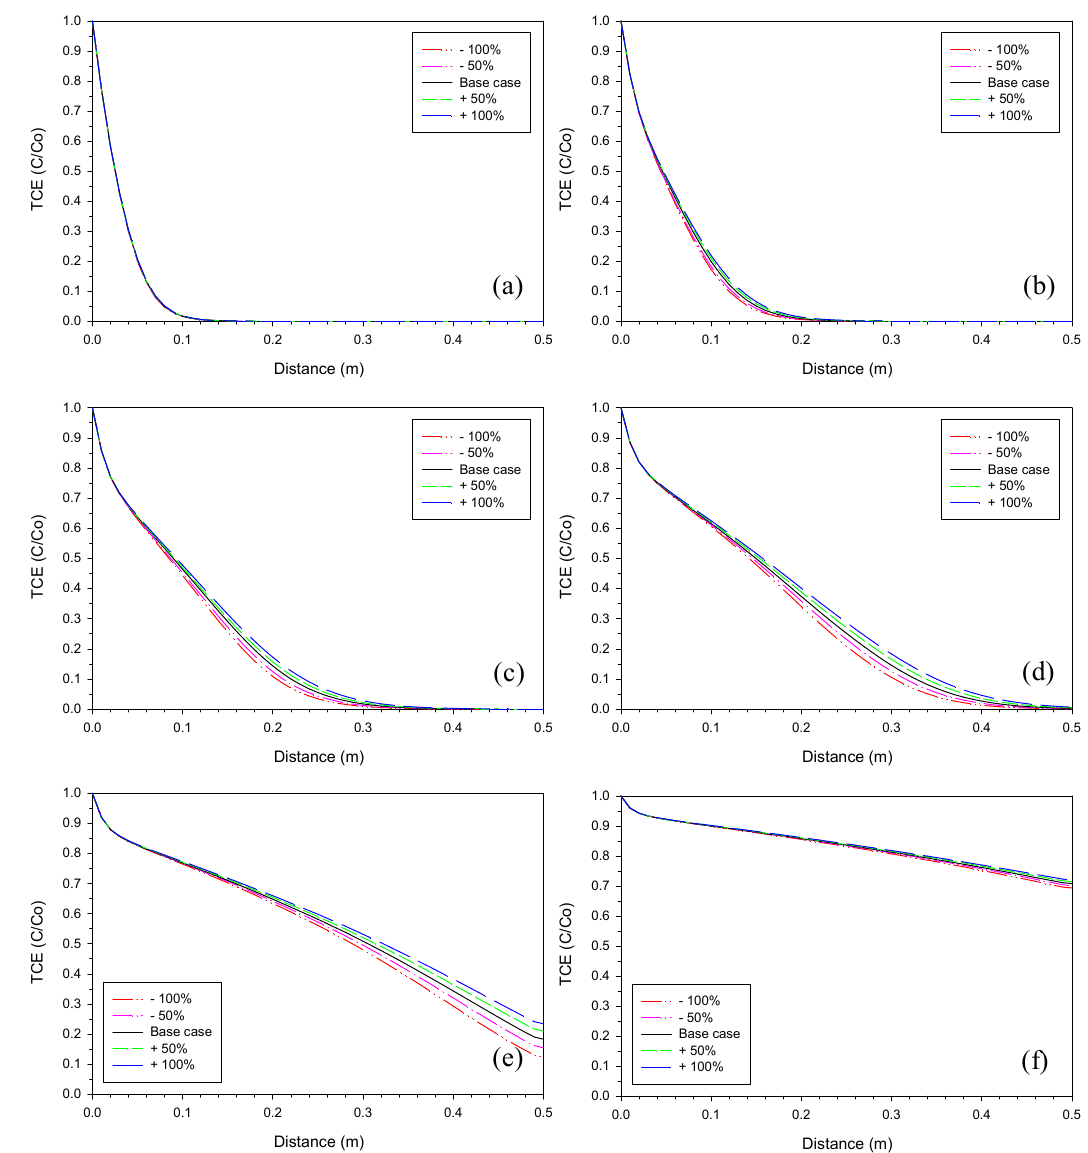
Figure 9. Sensitivity analysis of α 2 (proportionality constant for Fe 2 (OH) 2 CO 3 (s)). TCE profiles on ( a ) Day 4, ( b ) Day 25, ( c ) Day 54, ( d ) Day 87, ( e ) Day 164, and ( f ) Day 410 with value of the base case, +/−50% and +/−100%.